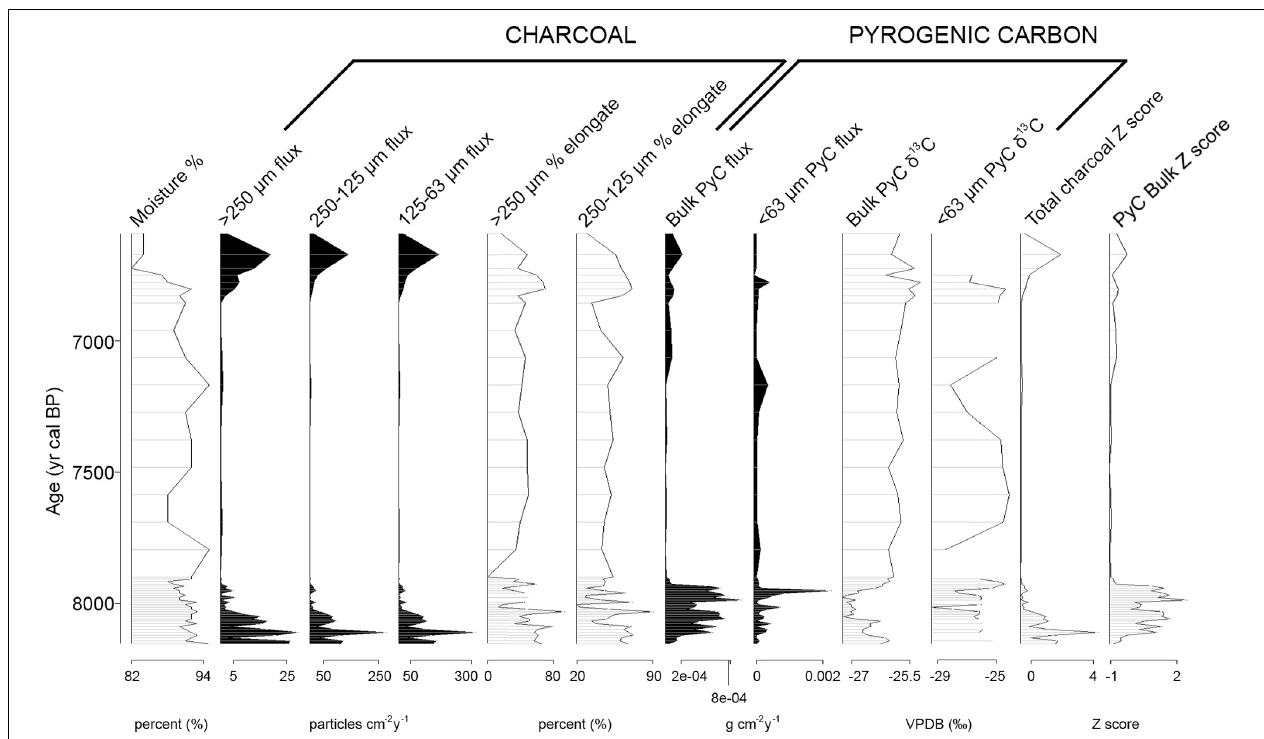
FIGURE 4 | Stratigraphic plot of data from Sanamere Lagoon core SAN1, plotted by age. Proxies plotted are sediment moisture (percentage), charcoal fluxes by size fraction, charcoal elongate particle percentages, pyrogenic carbon fluxes by size fraction, pyrogenic carbon δ 13 C, and Z scores for total charcoal particles and bulk pyrogenic